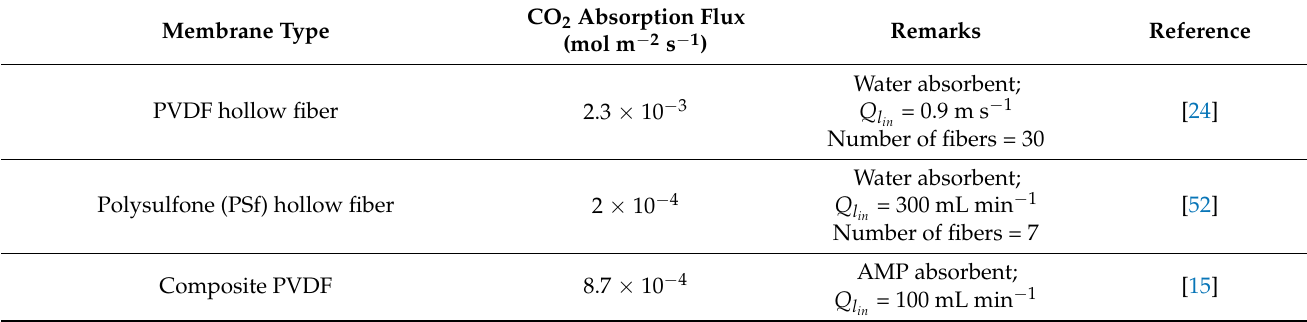
Table 6. Performance comparison of the composite membranes in this study and the literature. Membrane